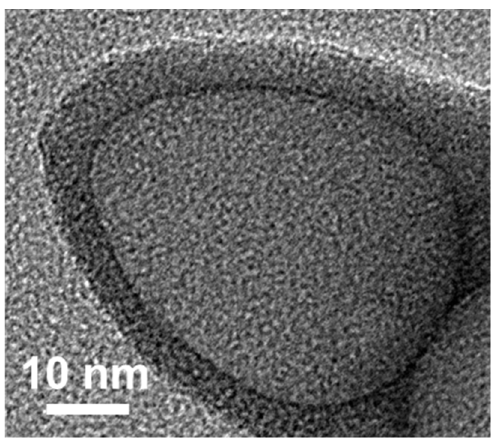
Figure 4. TEM image of PLHA-V0.